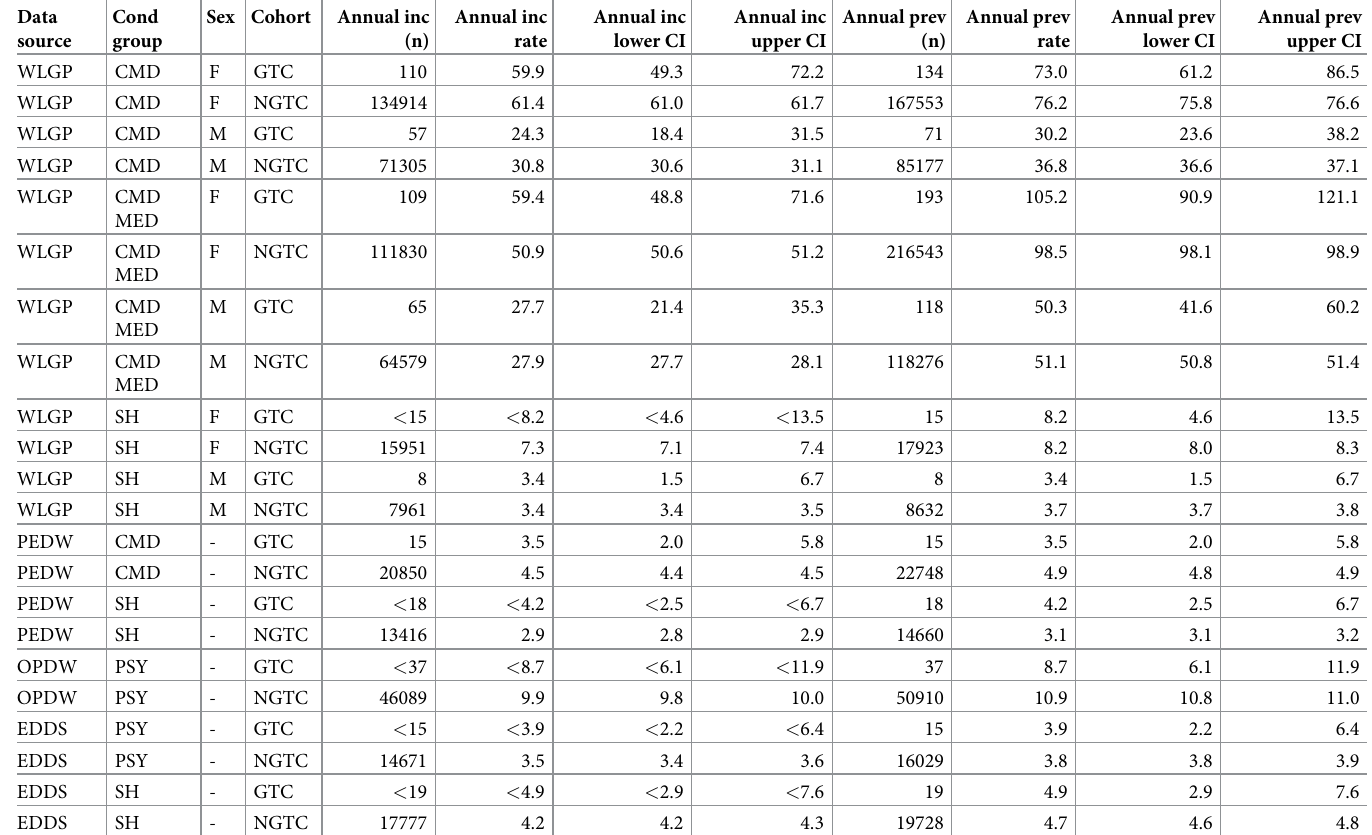
Table 6. Unadjusted incidence and prevalence rates per 1,000 PYAR, by data source and condition group (for all data sources), and by sex (for primary care only). Data